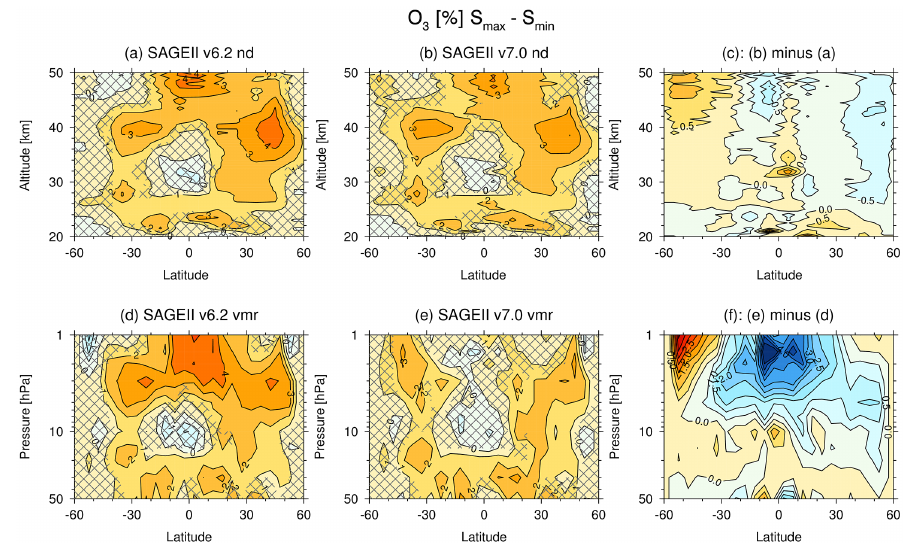
Figure 4. The percent (%) annual solar-ozone response (SOR) (per 130SFU) for the (a, d) SAGE II v6.2 data and (b, e) SAGE II v7.0 data in terms of (a, b) number-density–altitude coordinates and (d, e) volume-mixing-ratio–pressure coordinates. Panel (c) shows (b) minus (a) , and panel (f) shows (e) minus (d) . The contour interval is 1% in panels (a, b, d, e) and 0.5% in panels (c, f) . The hatching denotes regions where the SOR is not statistically distinguishable from 0 at the 95% confidence